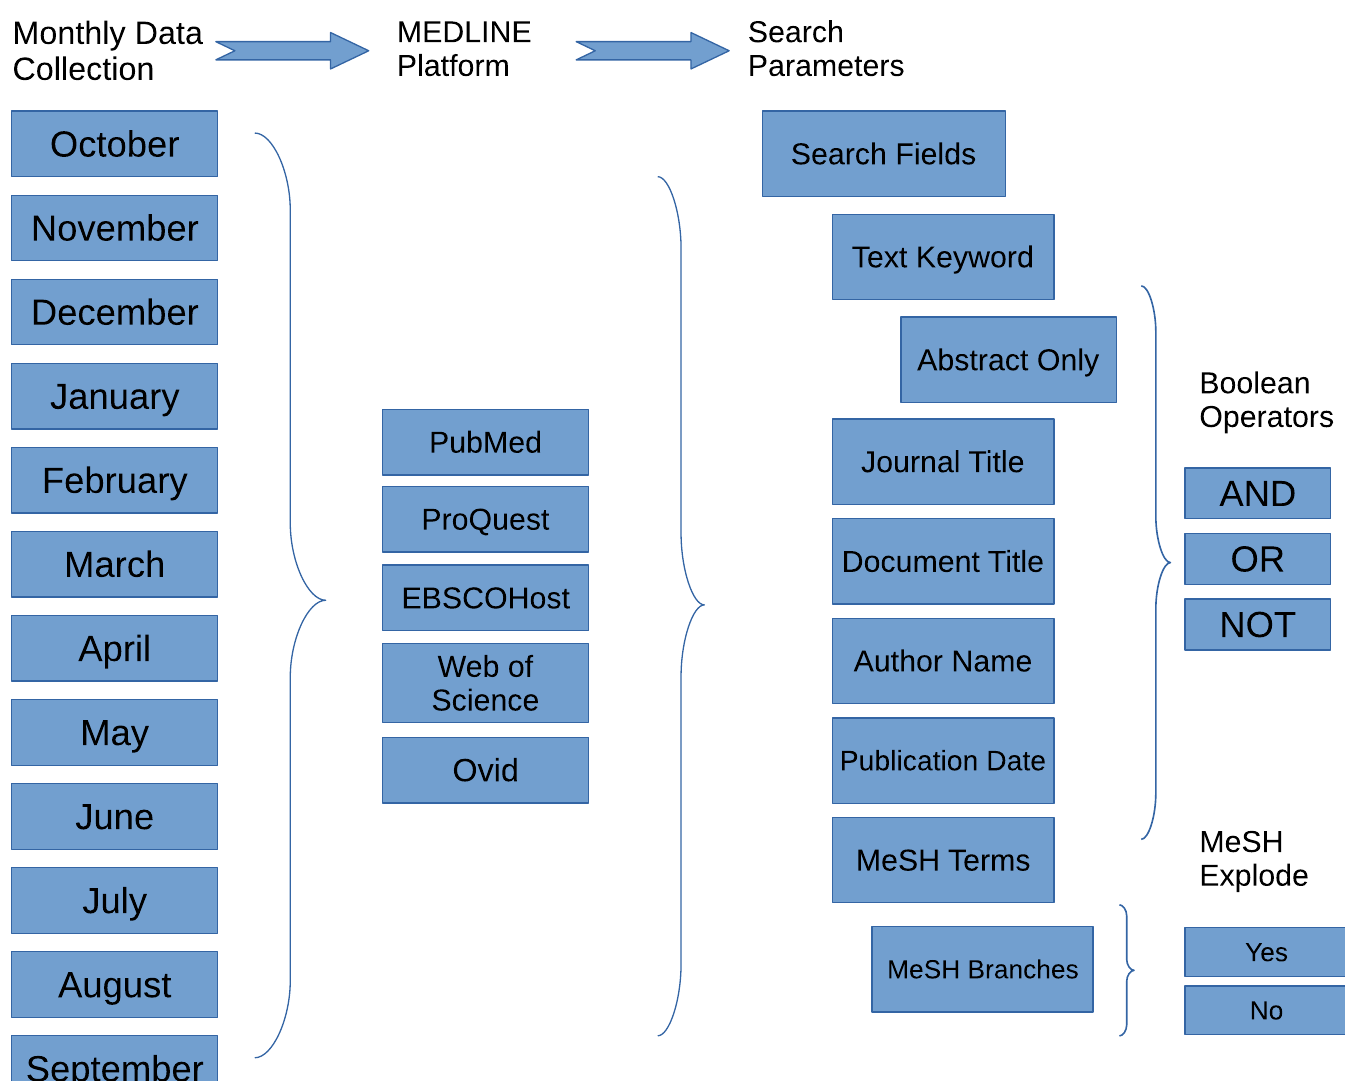
Fig 1. Data collection method. Diagram outlining the research process used to collect data. Each month we ran 145 searches (29 cases) on the five MEDLINE platforms using the specified search parameters.